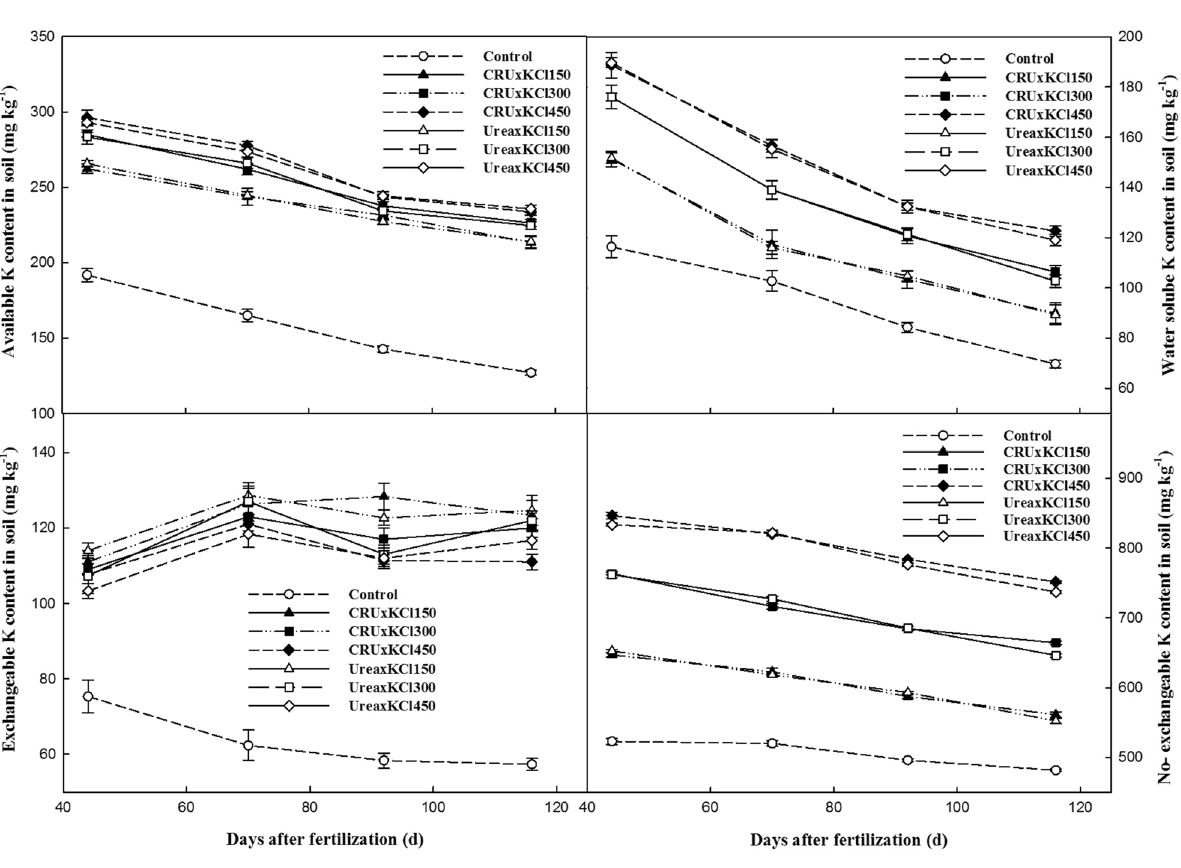
Figure 3. Changes in the soil K